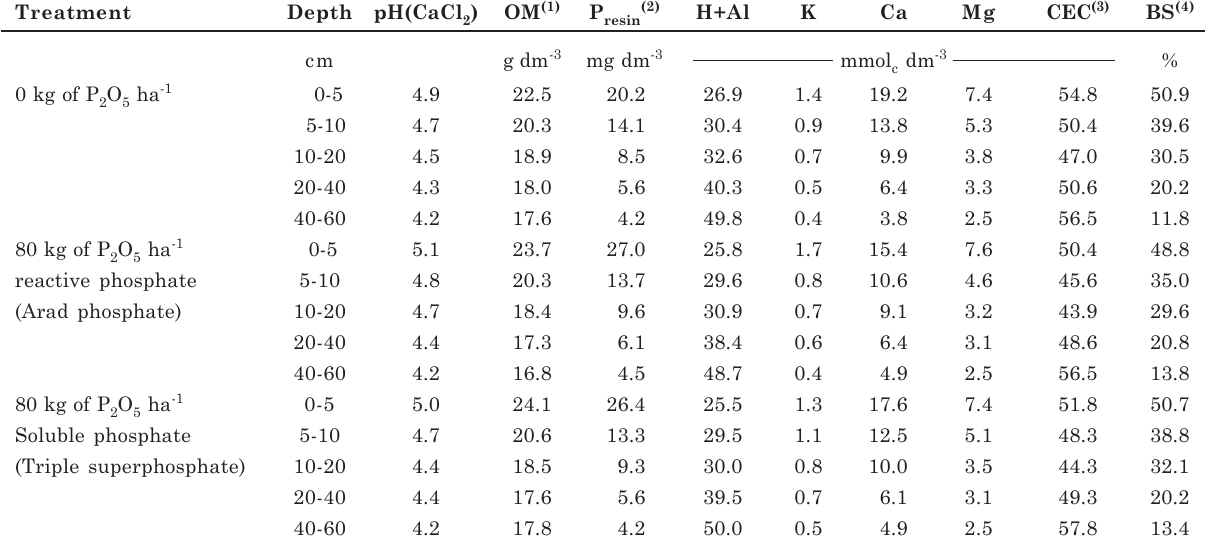
Table 1. Selected chemical characteristics of the soil of the experimental area at the beginning of the experiment (March Treatment